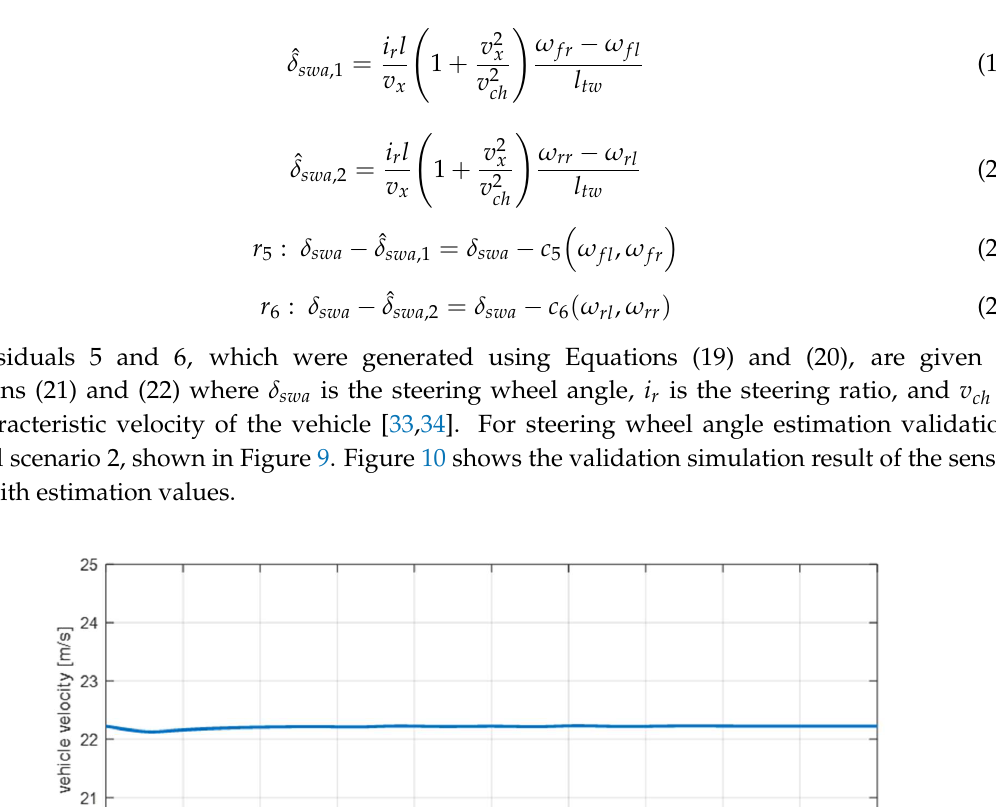
Table 1. Parameters semi-correlation table of wheel angular speed residuals.